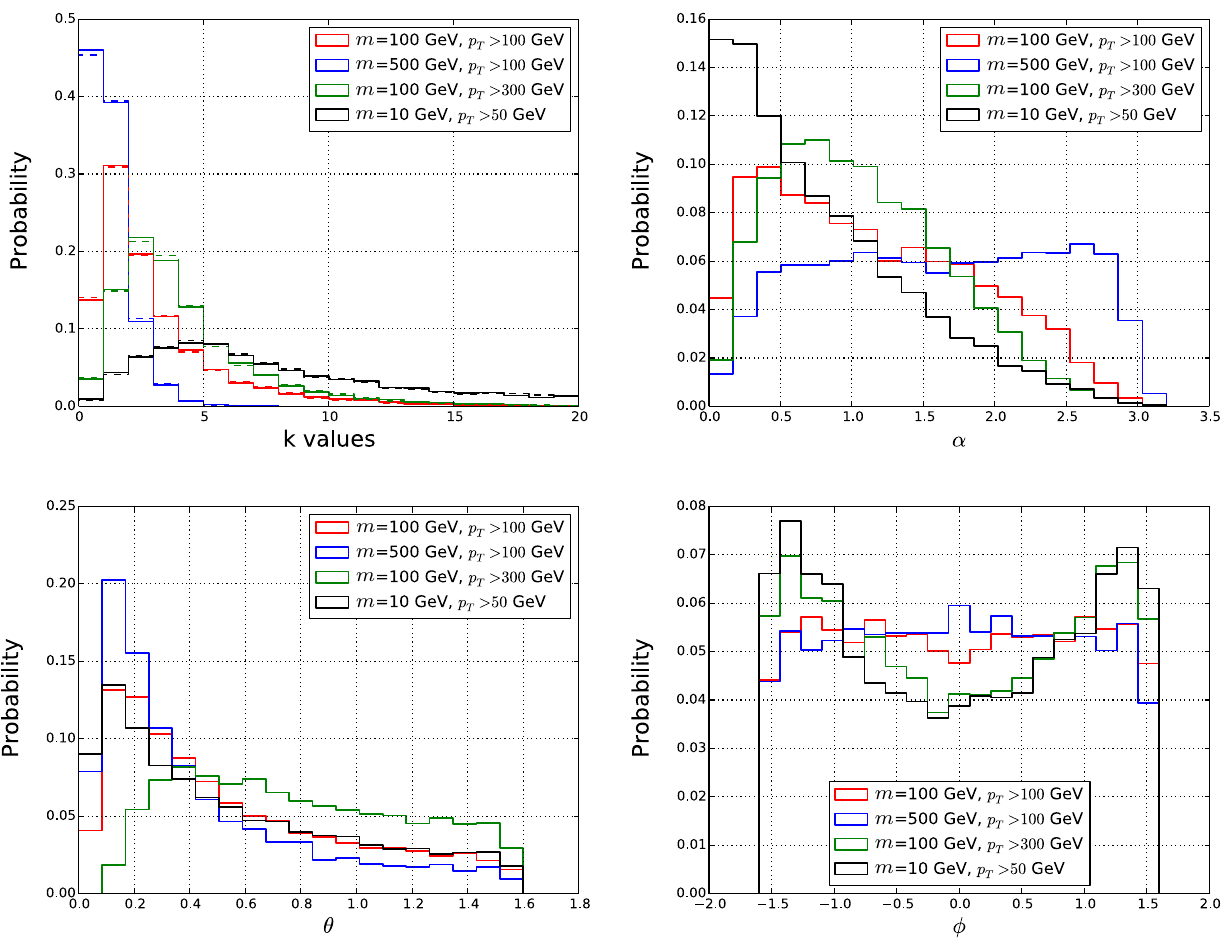
Fig. 1 Distributions of quirk initial kinematic variables for different quirk masses and quirk-pair system transverse momenta. In the upper-left panel, the solid and dashed lines correspond to k 1 and k 2 ,